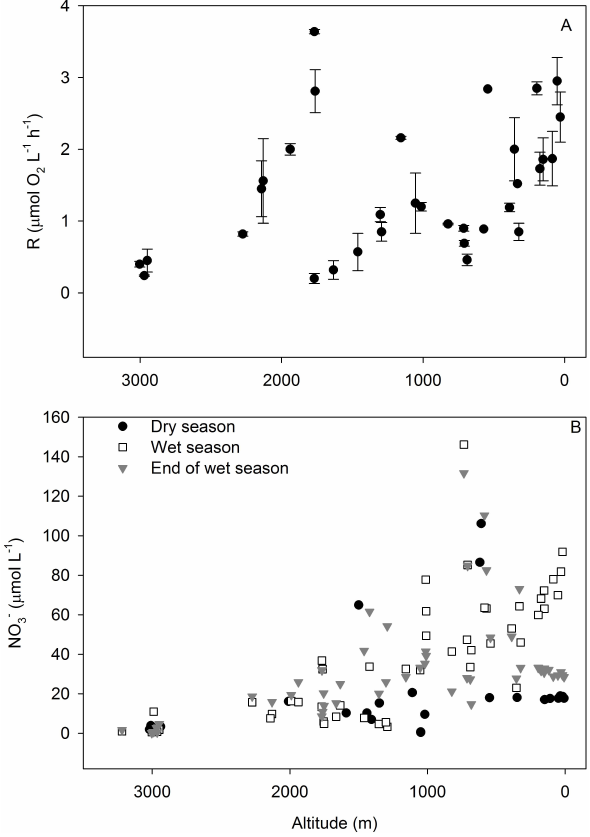
Fig. 8. Altitudinal profile of (A) respiration rate during the 2009 wet season, and (B) nitrate concentrations along the Tana River basin during the three sampling